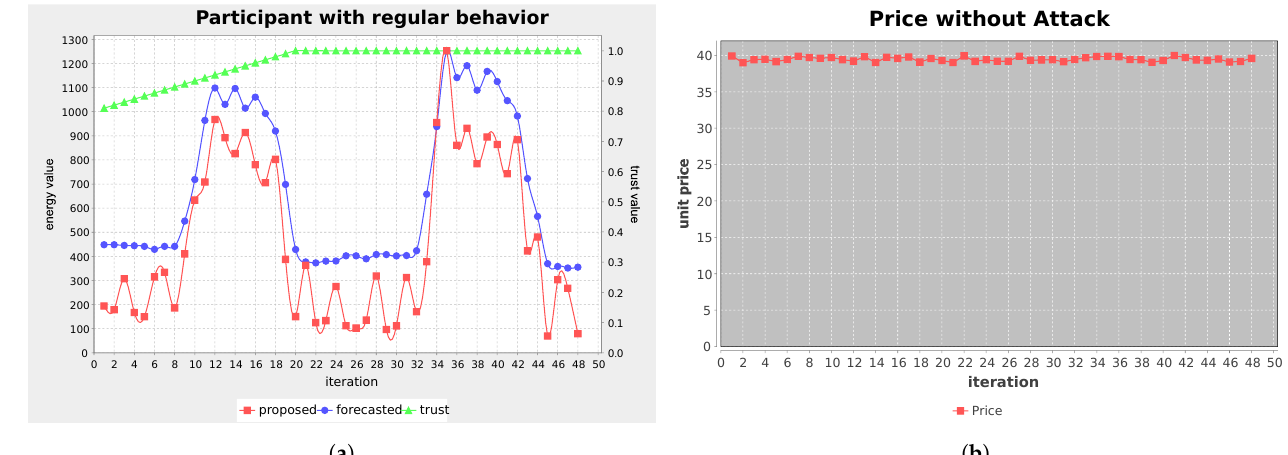
Figure 2. Scenario 1. ( a ) Participant evaluation without attack; ( b ) Agreed price without